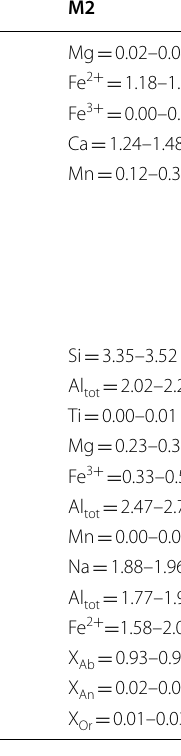
Table 2 Intervals of compositional variations in minerals marking different metamorphic stages of garnet-bearing gneiss